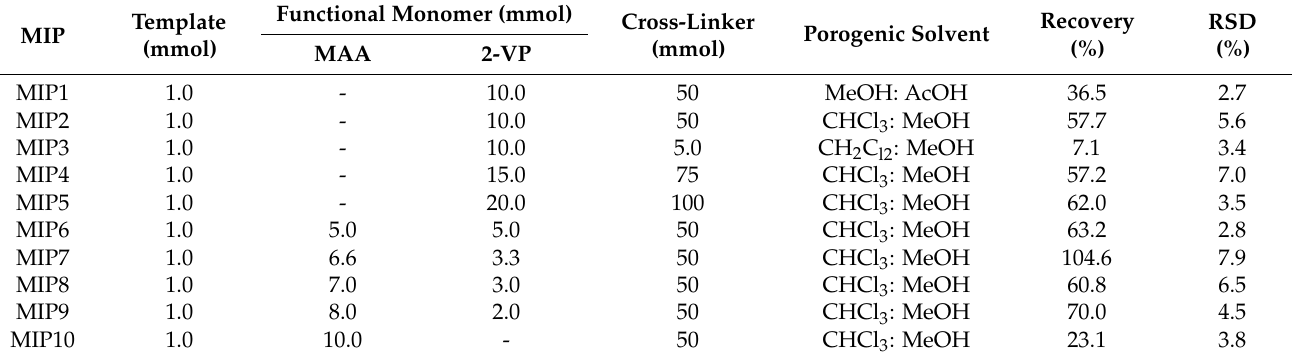
Table 1. Effect of the imprinted polymer preparation conditions on extraction recovery of CIP in water, (SPE